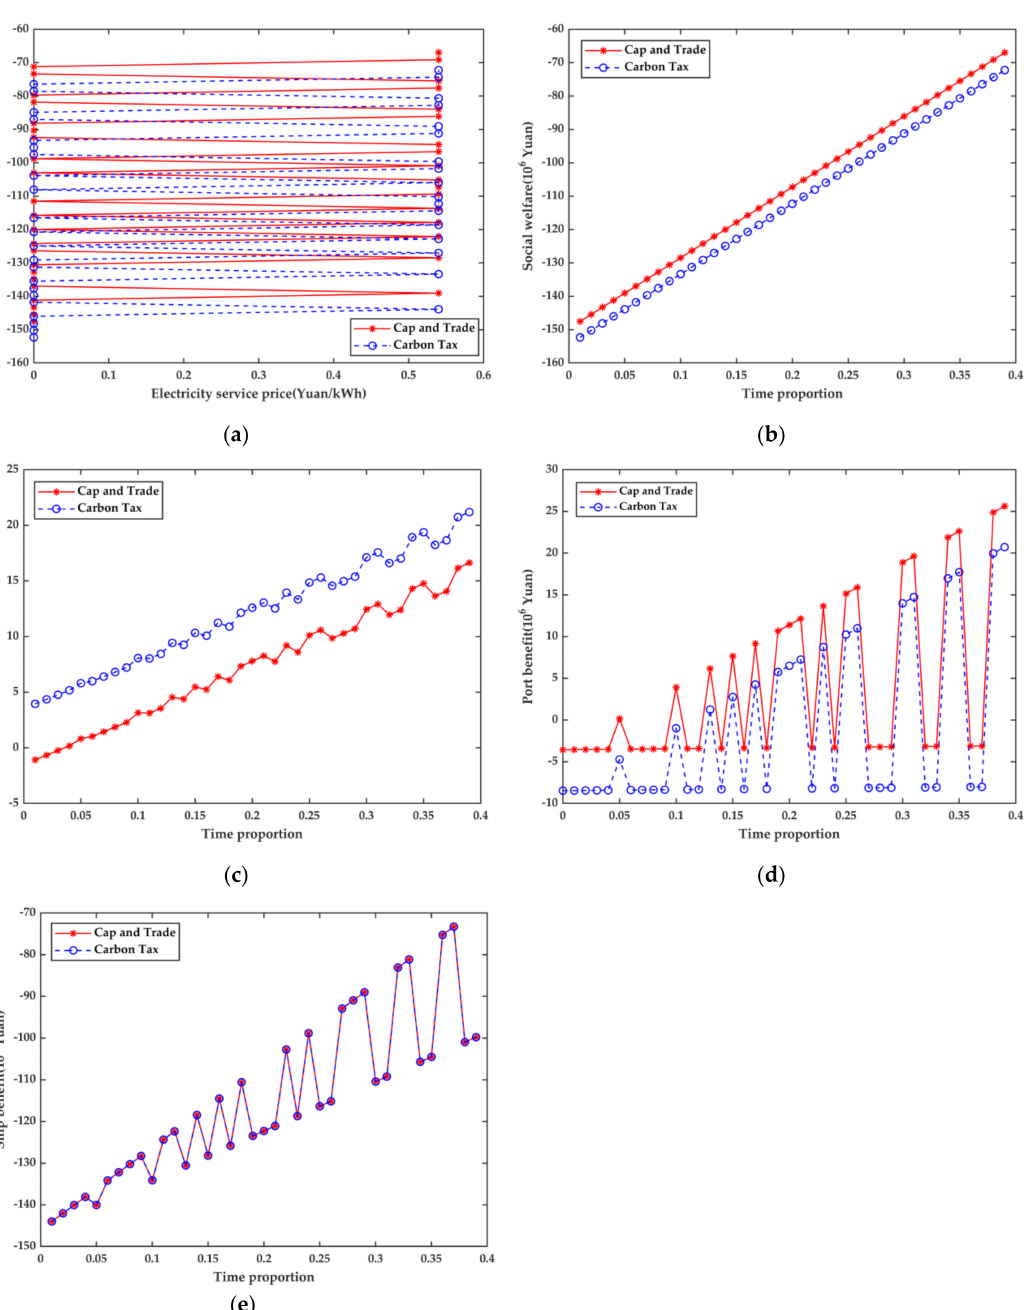
Figure 8. The relationship between time proportion and the benefits to all parties. ( a ) The relationship between electricity service price and social welfare; ( b ) The relationship between time proportion and social welfare; ( c ) The relationship between time proportion and government benefit; ( d ) The relationship between time proportion and port benefit; ( e ) The relationship between time proportion and ship